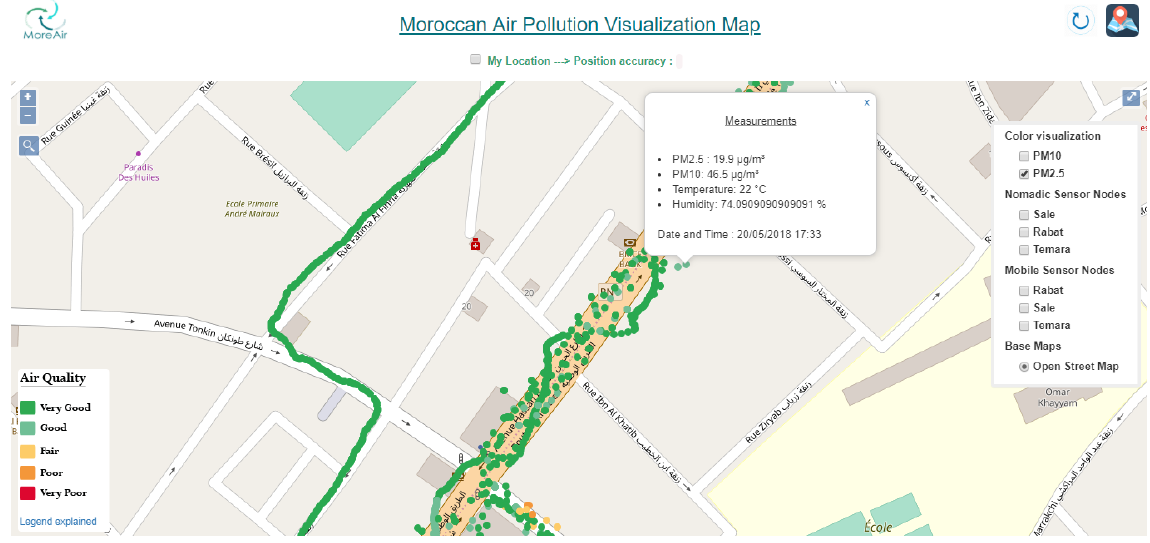
Figure 18. PM 2.5 measurements in a neighborhood of Rabat